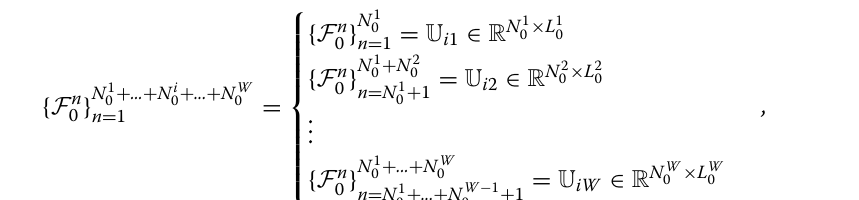
Fig. 3 FCN architecture in the case of two data types. Here N 1 channels (possibly different) of the two NN branches; N 1 and N 2 represent the number of filters adopted. For sake of clarity, the dimensionality of the building blocks has been enhanced: a three-dimensional parallelepiped is used to depict the two-dimensional output of each convolutional layer; a two-dimensional rectangle is used to depict the one-dimensional output of the global pooling layer and of the softmax